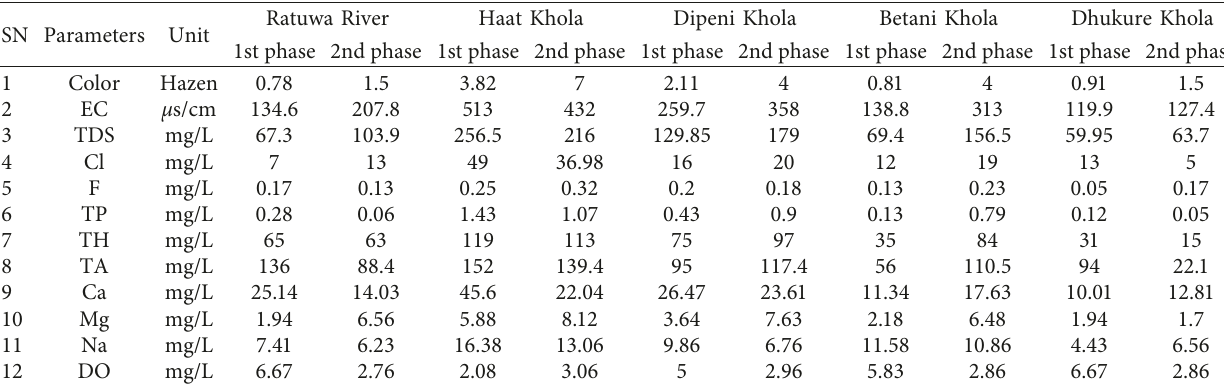
Table 1: Analysis of physicochemical parameters of different rivers in Damak with their units. SN Parameters Unit